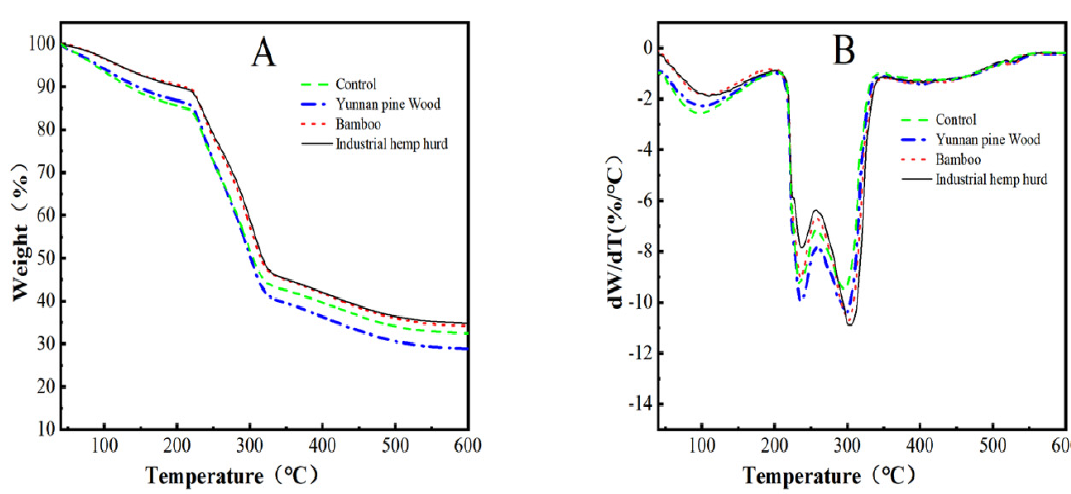
Figure 5. Effect of addition of Yunnan pine wood, bamboo culms, or industrial hemp hurd fibers obtained by pectinase + hemicellulase treatment on ( A ) TG and ( B ) DTG curves of eucalyptus bark CMC composite films.